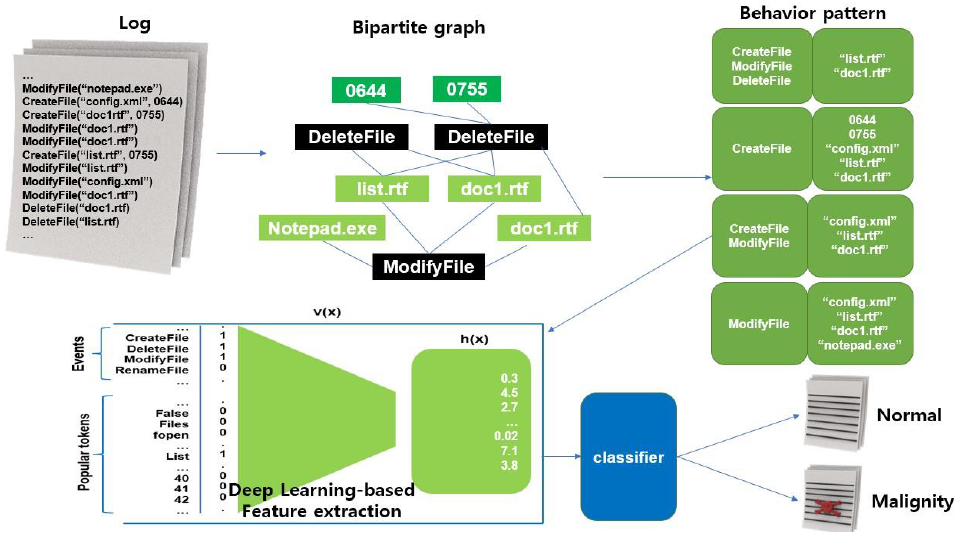
Figure 6. Post-execution processing process.